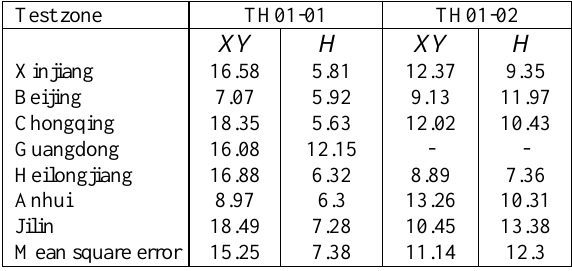
Table 6. Positioning accuracy without ground control points using calibration parameters in calibration fields of Beijing to offset that of the other fields （ X , Y ： Gauss-Krueger Projection ， H ： Geodetic height ， Unit ： m ） From table 4 and table 6, we can see that: